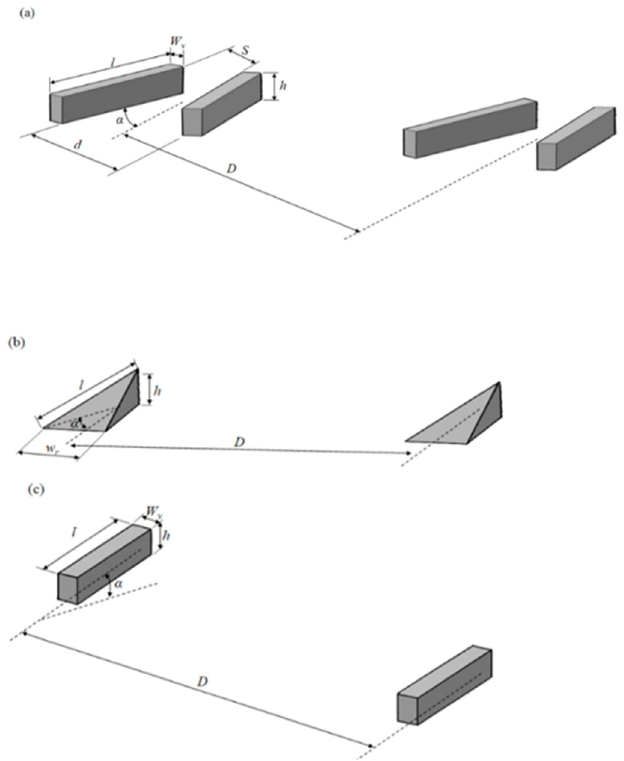
Figure 3. Normalized velocity pro fi les for M = 0.64 and 0.83. of seven VGs was created. For the CRV type, the front, d , and rear, s , spacing are 1 δ and 0.5 δ , respectively.